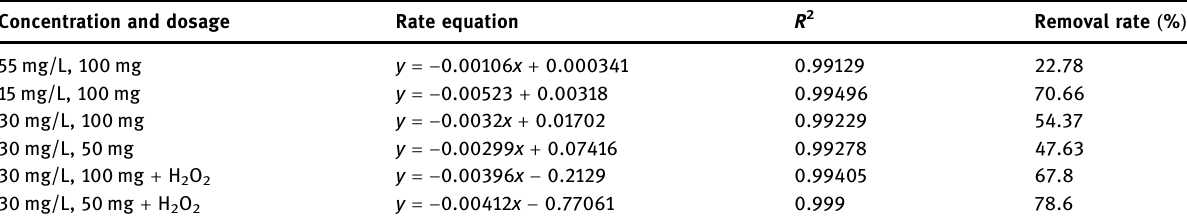
Table 1: Parameters of the process of tetracycline degradation by Zn - MOFs Concentration and